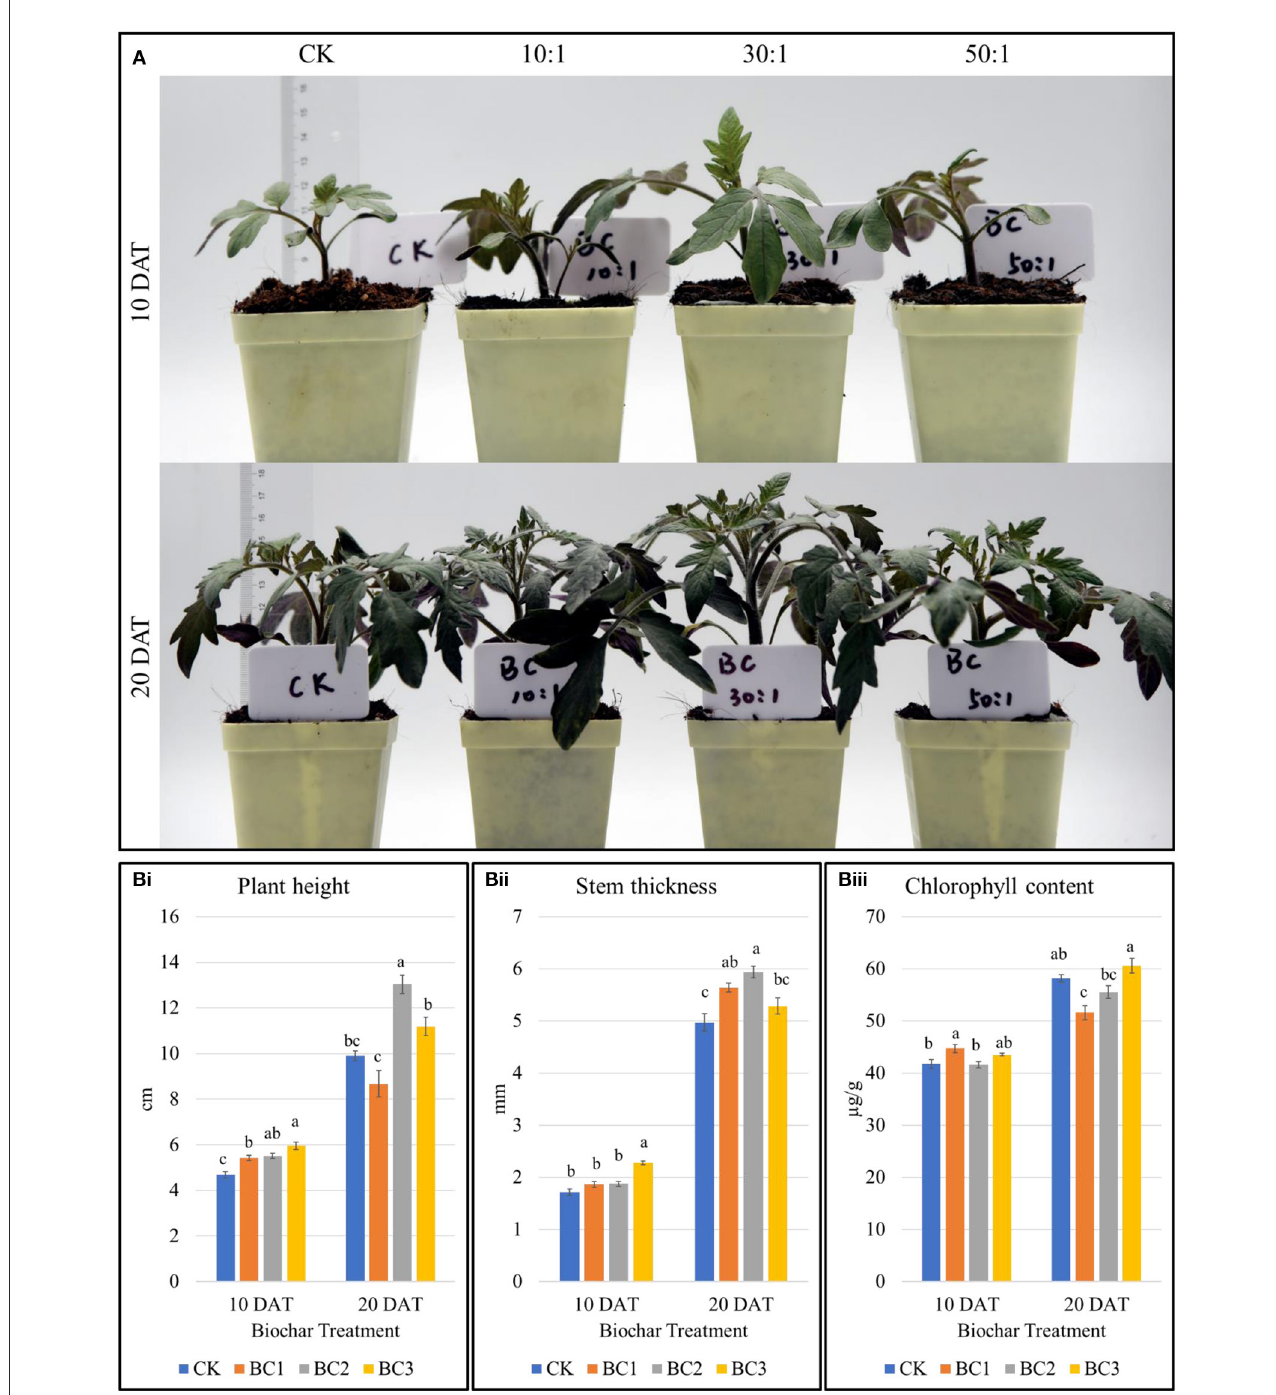
FIGURE1 (A) Phenotypes of the tomato plants grown in three different coconut bran and bamboo charcoal combinations. (B i ) Plant height (B ii ) , stem thickness, and (B iii ) chlorophyll content in tomato leaves grown in BC1 (10:1), BC2 (30:1), and BC3 (50:1). The bars show mean ± SEM ( n = 11). Different letter in figure b indicates that differences in treatments are significant ( p <